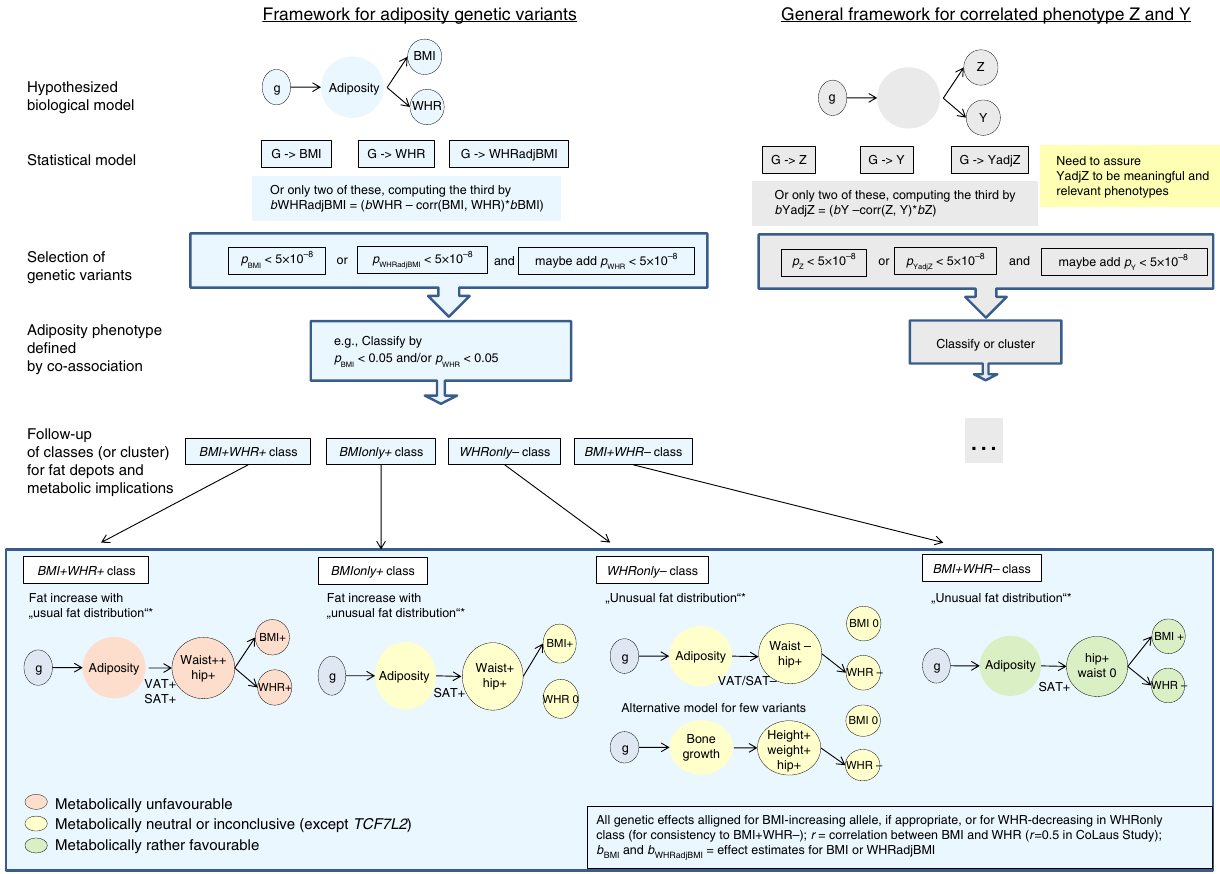
Fig. 7 Approach, biological models, and general framework. The fi gure depicts our joint view on adiposity traits, the resulting hypothesized biological models for adiposity genetics, and a potential general